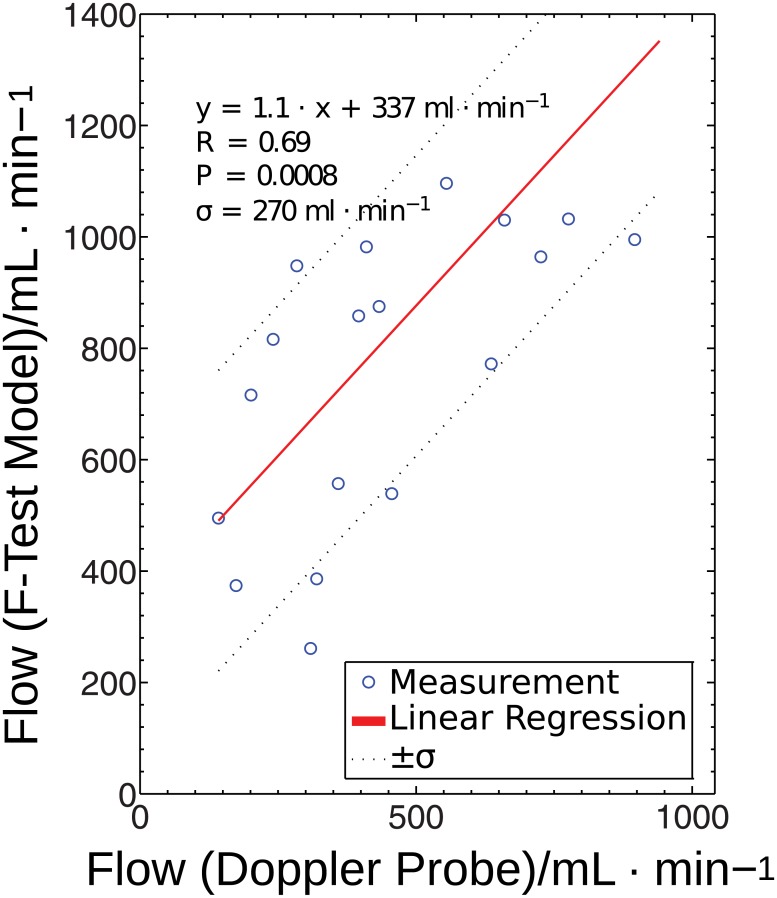
Regression of the uncorrected DCE-MRI model.Regression of the uncorrected DCE-MRI model results with the Doppler flow values for the F-test selection method. The solid line represents the linear regression fit of the measured data (circles). The dotted line depicts the standard deviation of the data related to the linear regression.